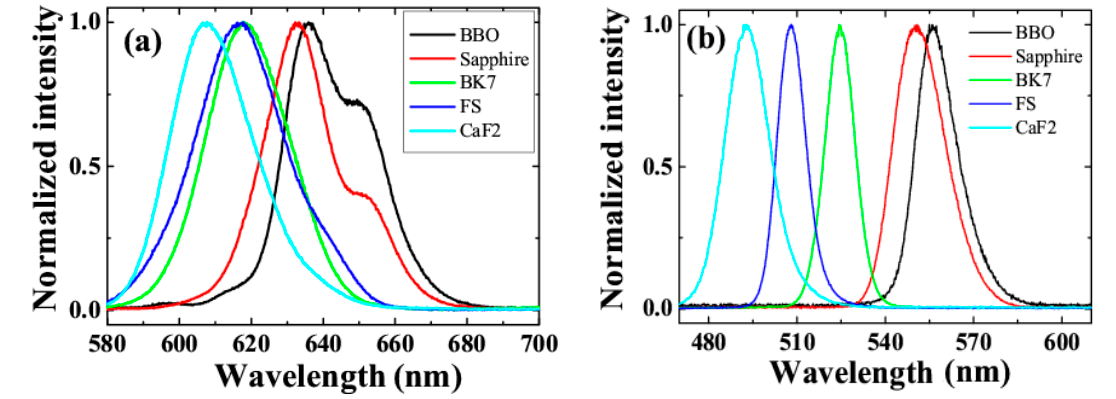
Figure 7. Spectra of ( a ) AS1 and ( b ) AS3 of five different materials with cross-angle of 1.8°